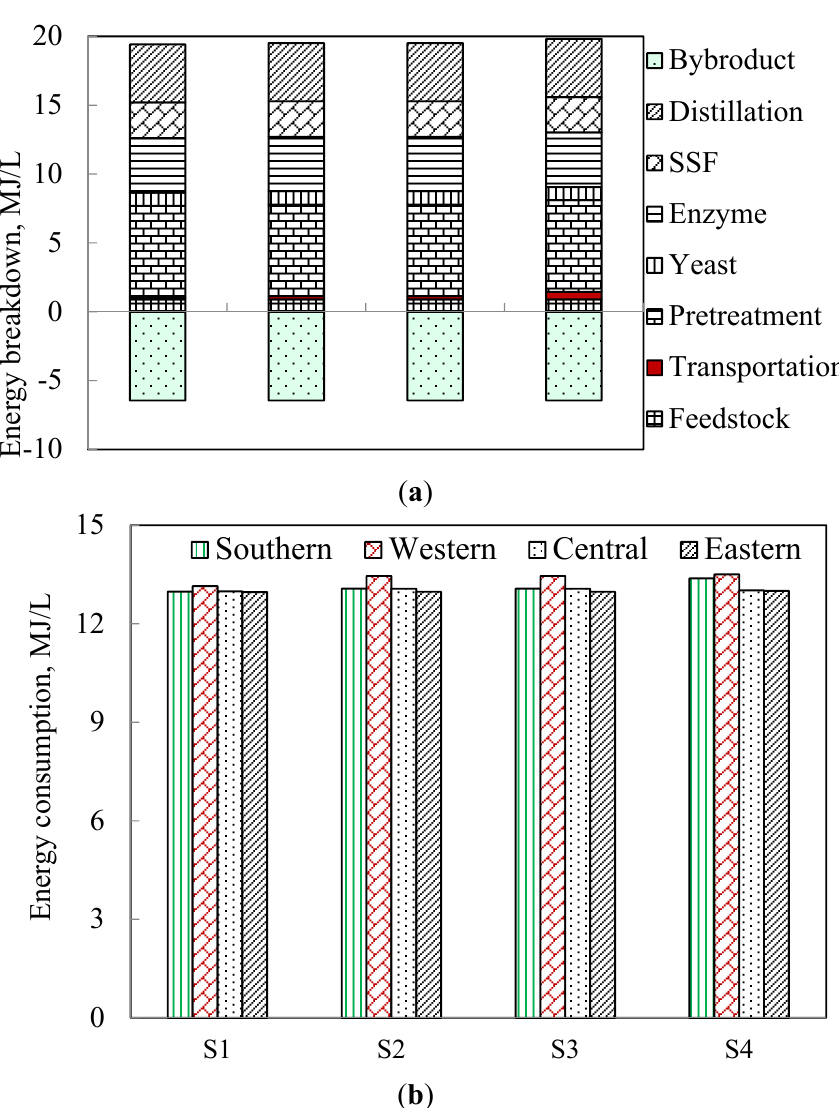
Figure 3. ( a ) Energy breakdown for different scenarios (Southern Ontario); and ( b ) net energy consumption at different location in